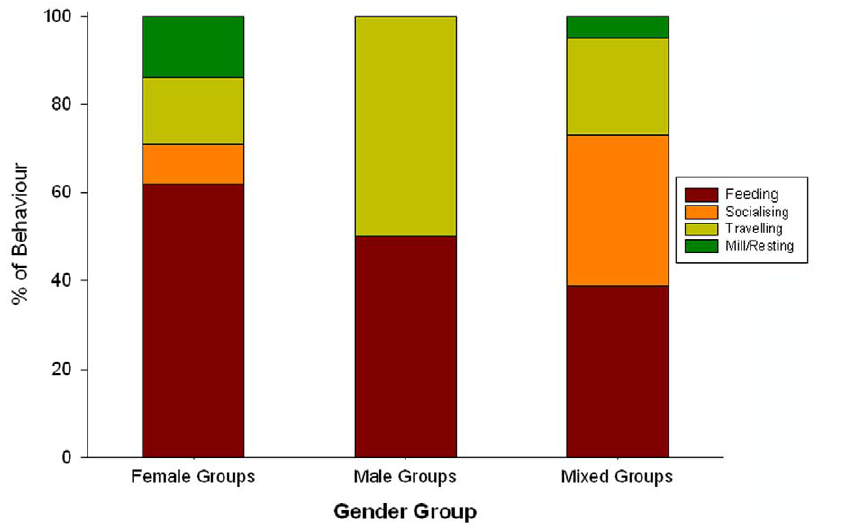
Figure 2. Frequency of dolphin behaviours for female (a), male (b), and mixed-sex (c) groups in the Clarence River estuary. * 76% of the total social interaction time (N=442) of mixed-sex groups involved aggressive coercive behaviour.